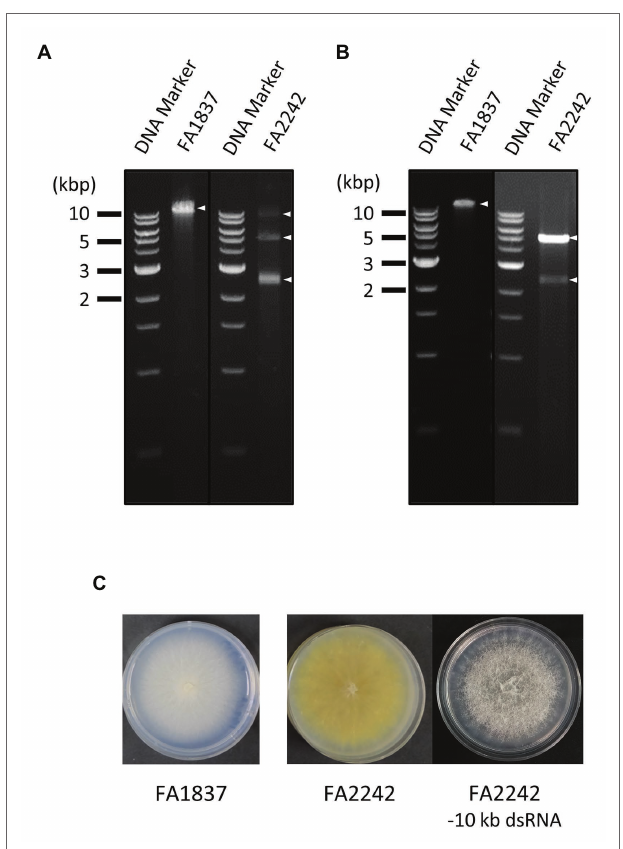
FIGURE 1 | Agarose gel electrophoresis of double-stranded (ds) RNA (dsRNA) samples used for direct RNA sequencing (DRS) and Illumina HiSeq, and colony morphology of the fungal strains. (A,B) Agarose gel electrophoresis of dsRNA fraction used for DRS (A) and Illumina HiSeq (B) extracted from the Fusarium sambucinum strains FA1837 and FA2242. The 1 kb DNA ladder (NEB) and dsRNA samples were loaded on the left and right lanes, respectively. The triangle indicates the position of a viral dsRNA band. (C) Colony morphologies of FA1837, FA2242, and an FA2242 variant lacking the 10 kb dsRNA. The 10 kbp dsRNA element may cause reduced colony growth and pigmentation and increased ariel